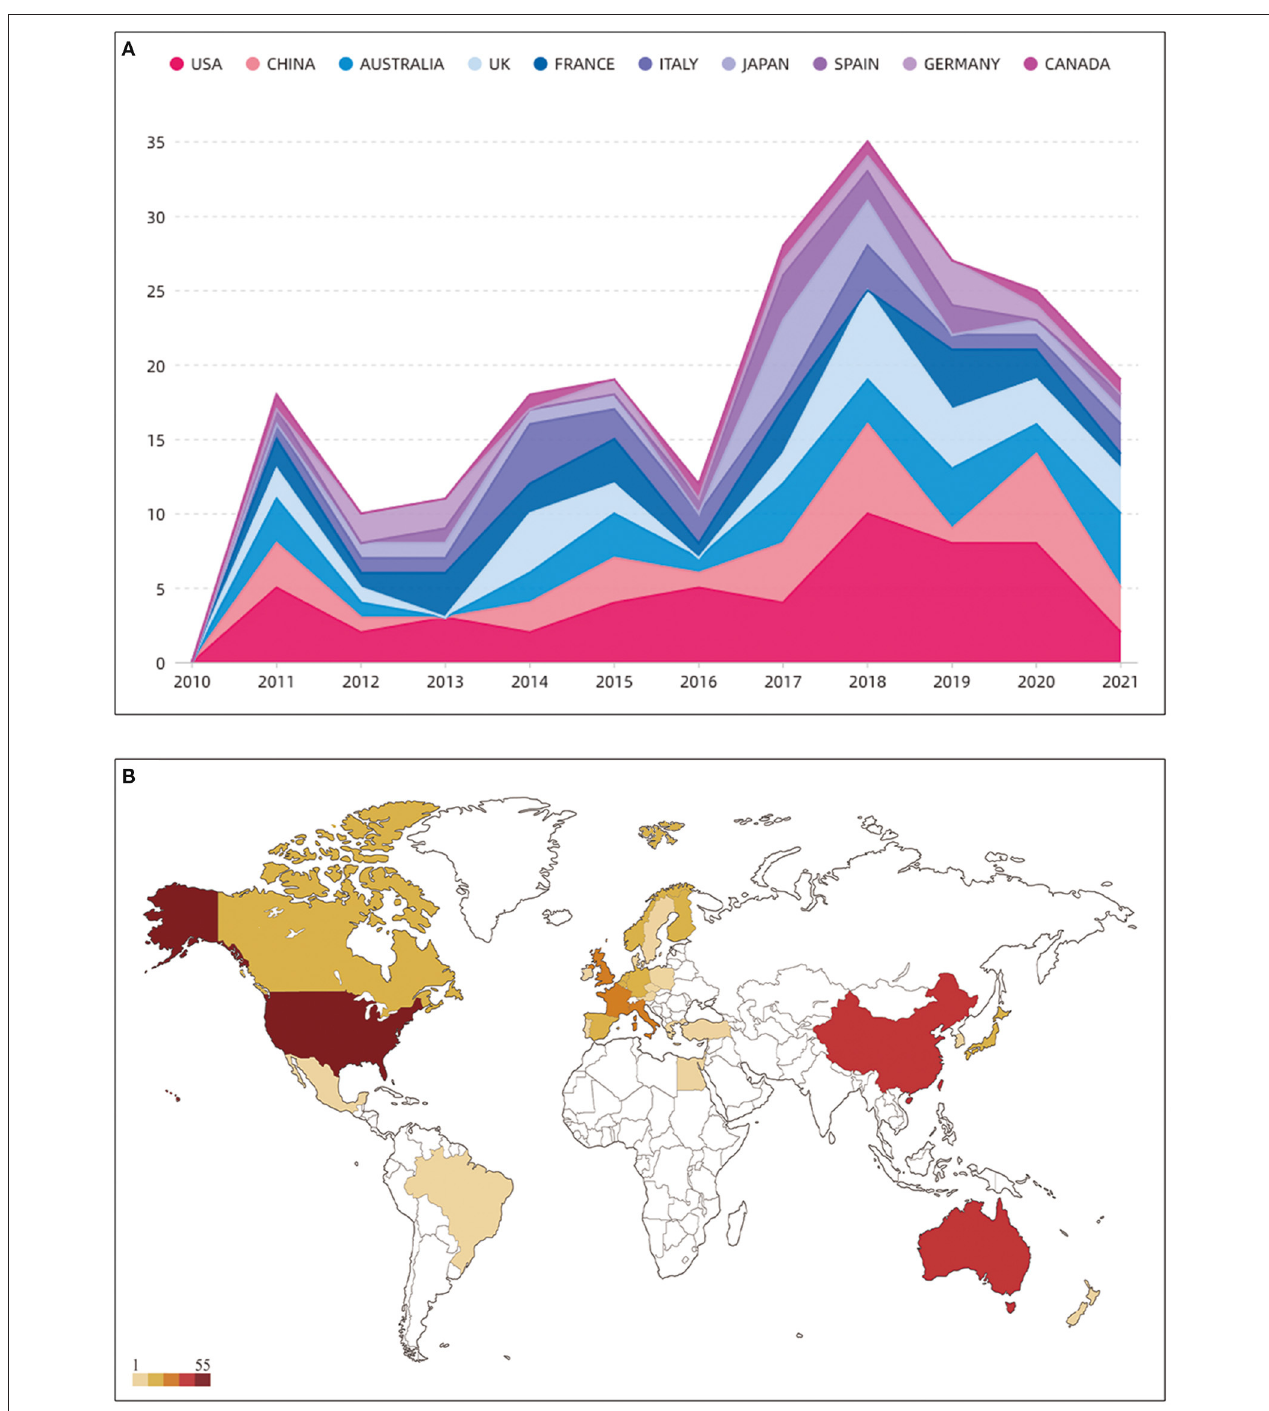
FIGURE 3 | (A) The growth trends of the top 10 countries in terms of the number of published articles from 2010 to 2021. (B) Geographical distribution of music therapy for dementia publications.